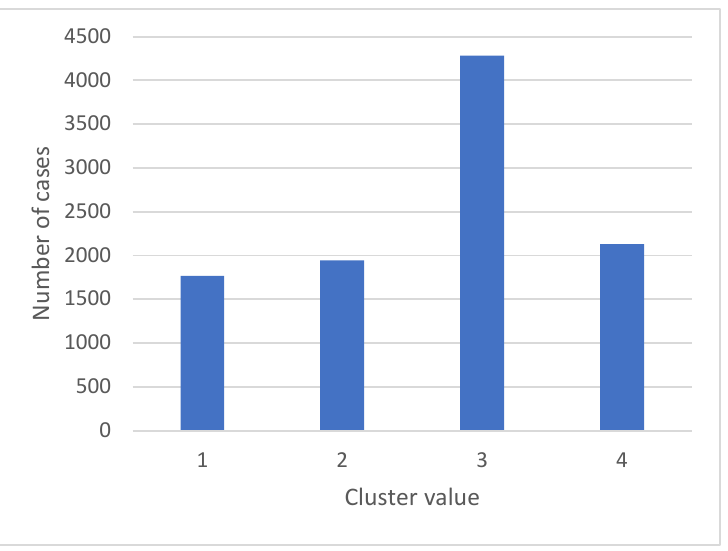
Figure 3. Number of clusters after using two-step clustering.